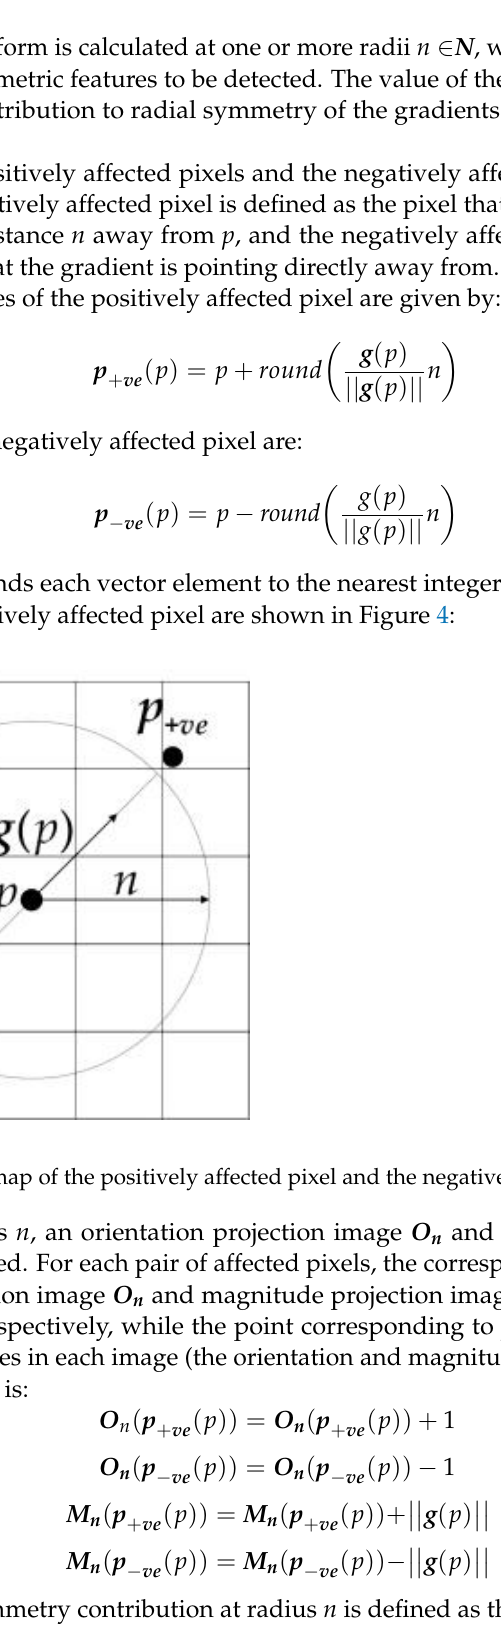
The radial symmetry contribution at radius n is defined as the convolution